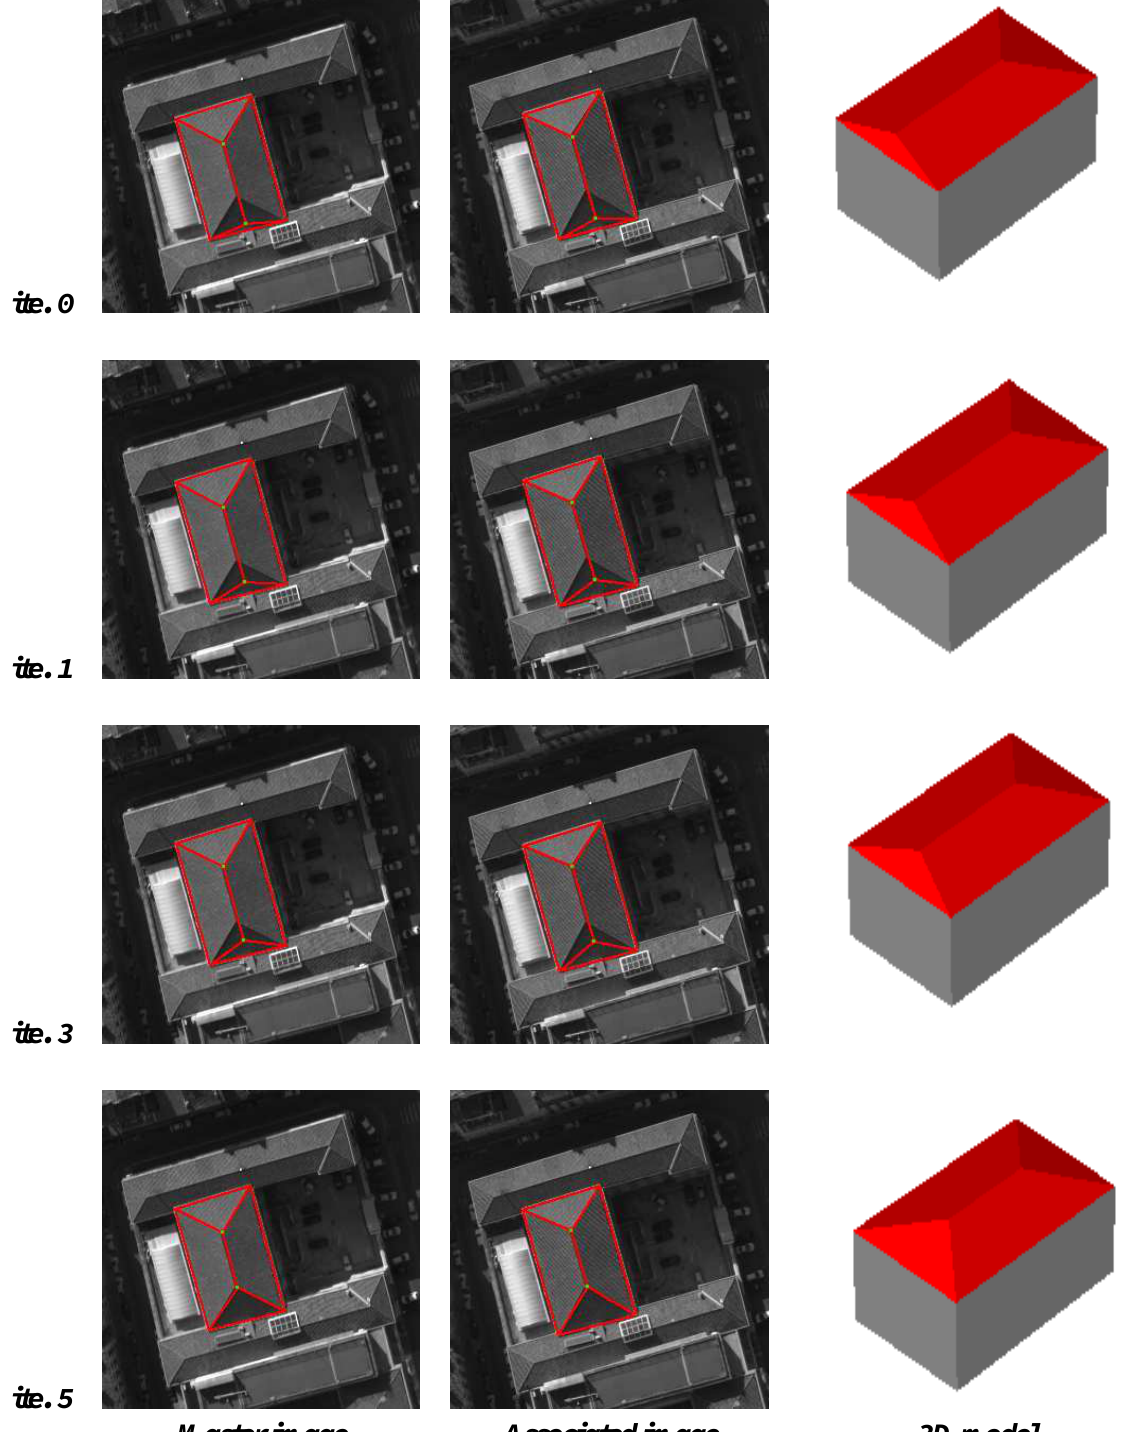
Figure 15. The best solution at several iterations of the Differential Evolution algorithm. The evolution of the 3D model and the footprint in the associated image is shown. The proposed algorithm converges to an optimal final solution in a few iterations.